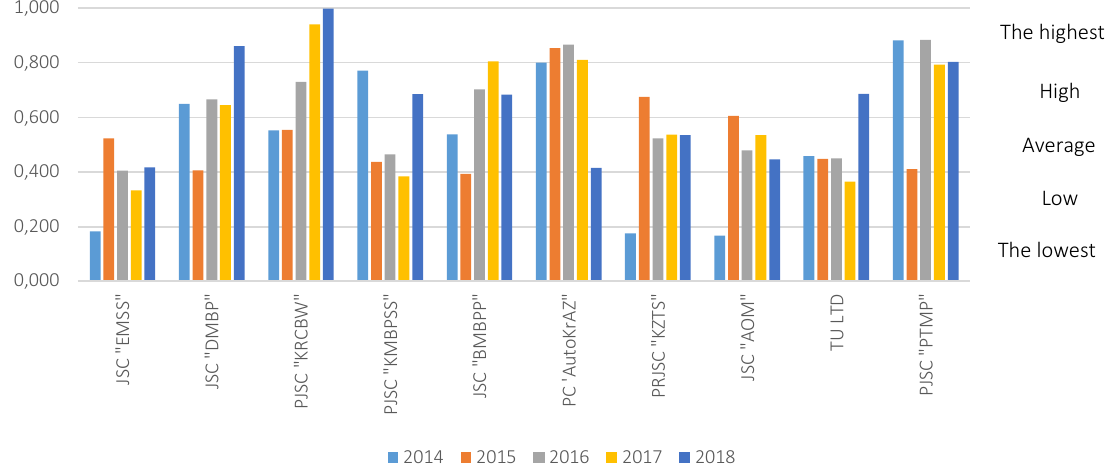
Figure 3. Dynamics of the taxonomy index change of machine-building enterprises for